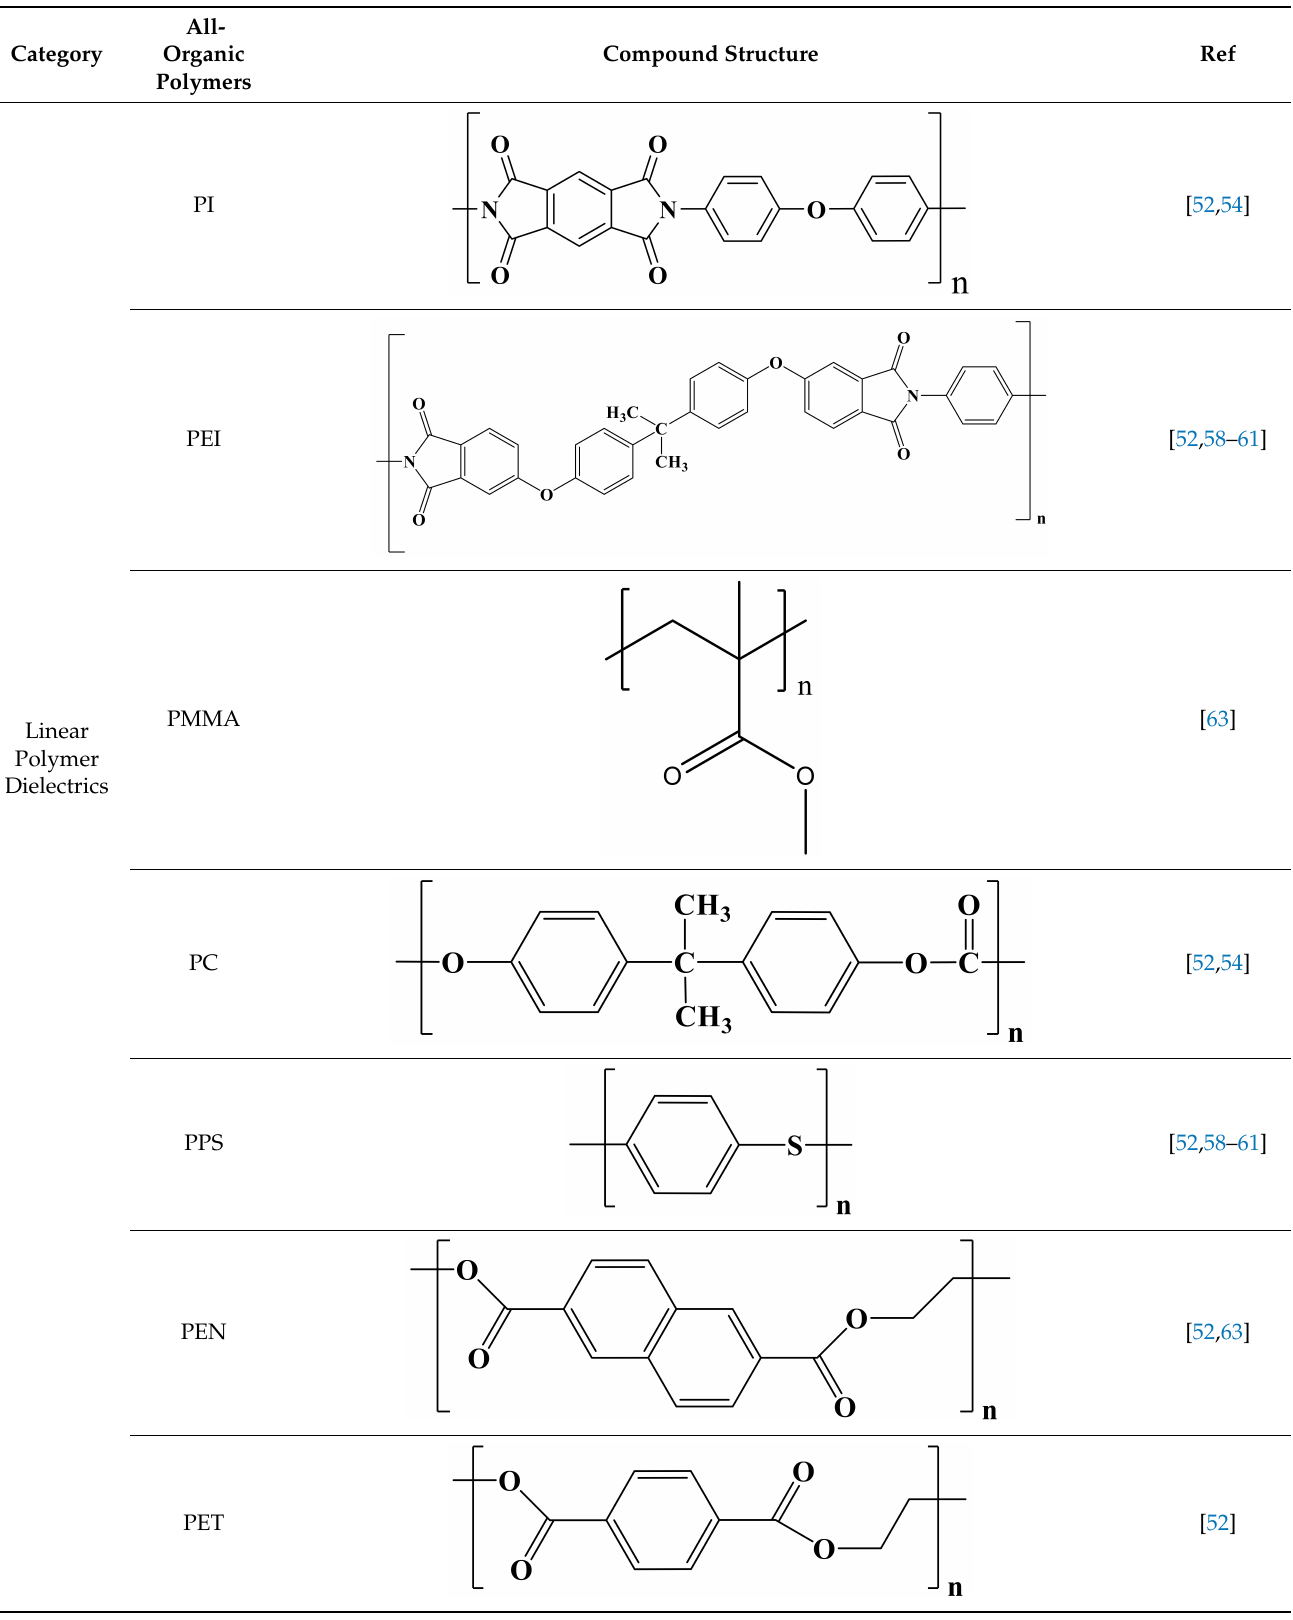
Table 2. Molecular Structure of Linear Polymer